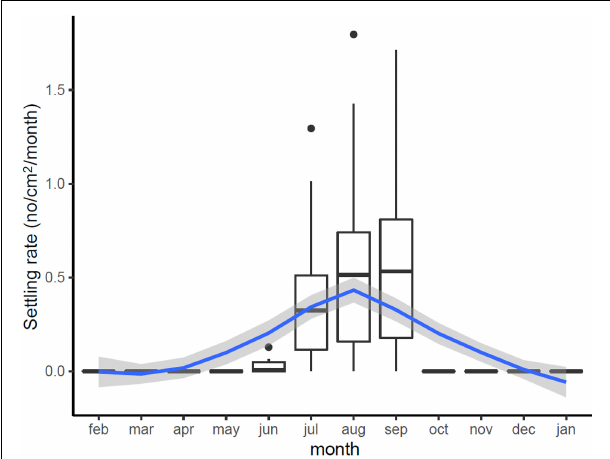
FIGURE 5 | Estimated variation in monthly settling rates (No. new recruits/cm 2 /month) across Cardiff Bay showing median values and interquartile range (boxplots) and smoothed fitted trend with 95CI envelope (blue and gray